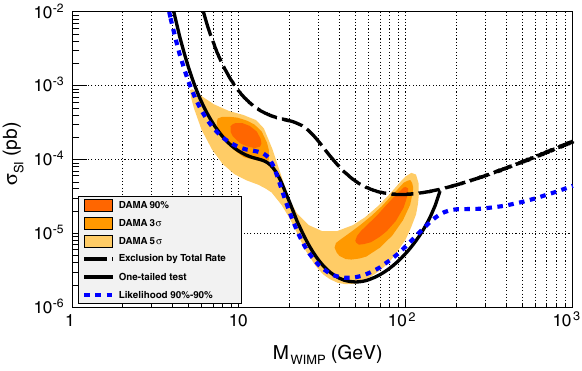
Fig. 4 Result of the maximum likelihood test ratio for the detection limit in the [2,6] keV ee window at 90% C.L. (when critical limit is at 90% C.L.) with 40 energy bins and segmented detector of ANAIS-112 after 5 years of measurement (short dashed blue line). The exclusion by total rate for the spin-independent WIMP-nucleon cross section of ANAIS-112 is the long dashed black line. DAMA/LIBRA regions at 90%, 3 σ and 5 σ are also shown [21]. The detection limit (Sect. 3.1.1) is the solid black